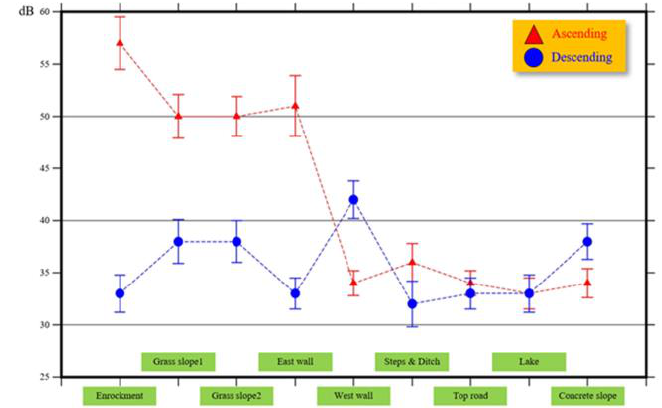
Figure 9. The average intensity of the dam surface in ascending and descending TSX-SL images.